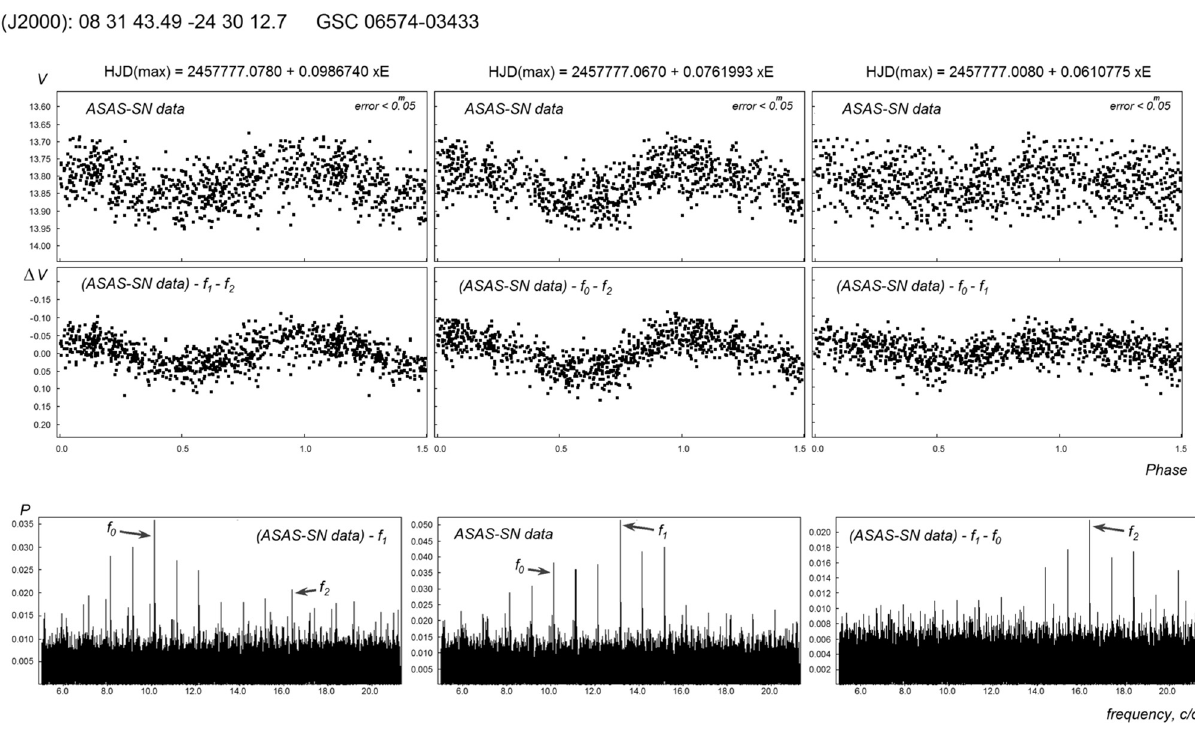
Figure 3: GSC 06574 - 03433 ( No. 3 ) .